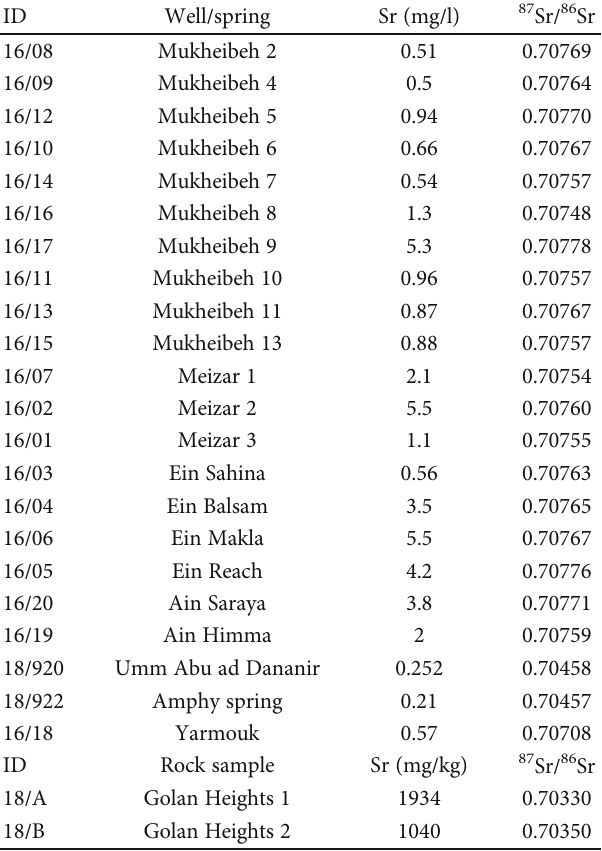
Table 3: Sr 2+ concentration and 87 Sr/ 86 Sr isotope signatures of groundwater and rocks from the Lower Yarmouk Gorge and surrounding